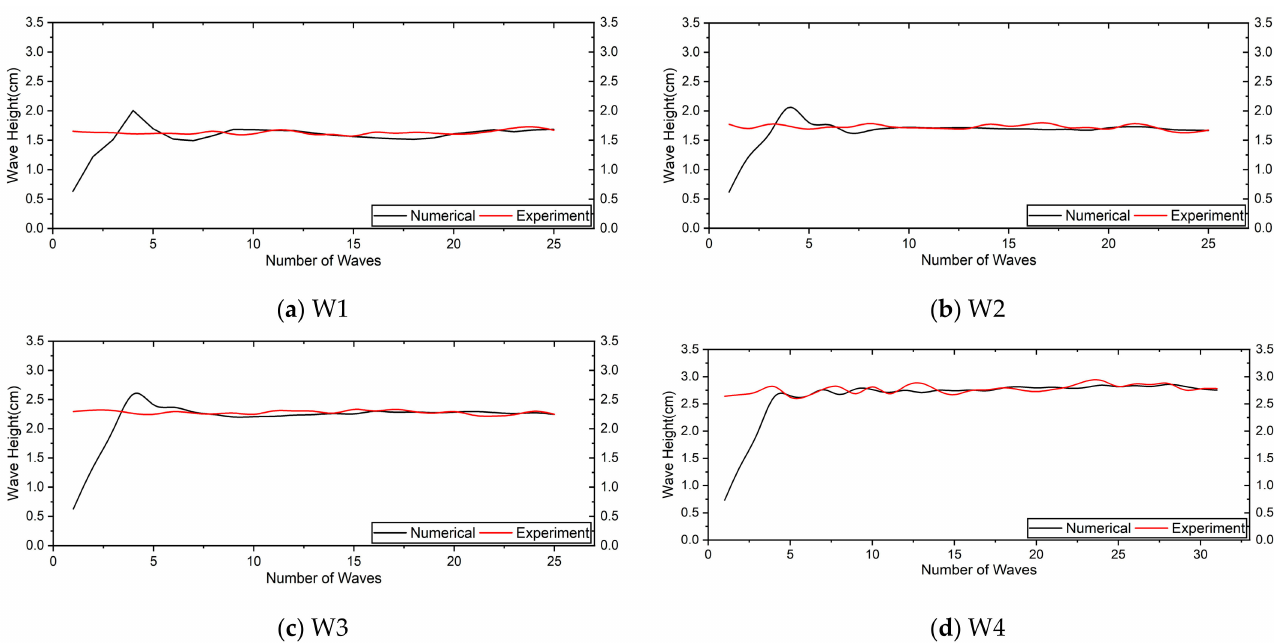
Figure 7. Wave heights at corresponding wave conditions at different measured positions: ( a ) T-2.22 s ( r = 264 cm), ( b ) T-2.22 s ( r = 300 cm), ( c ) T-2.22 s ( r = 336 cm), and ( d ) T-1.82 s ( r = 369 cm). Black line-numerical results and red line-experimental